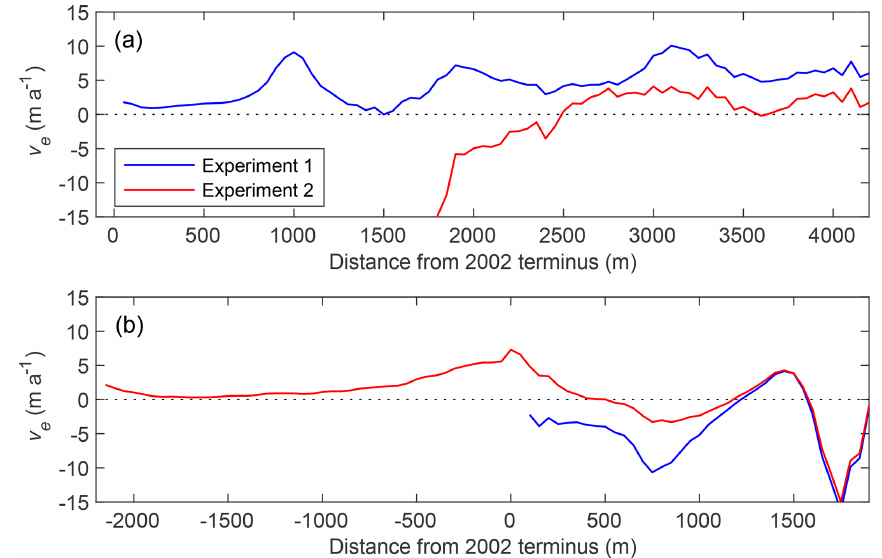
Figure 8. Calculated emergence velocity ( v e ) for Experiment 1 and Experiment 2 along the central flow lines of (a) Thorthormi and (b) Lugge